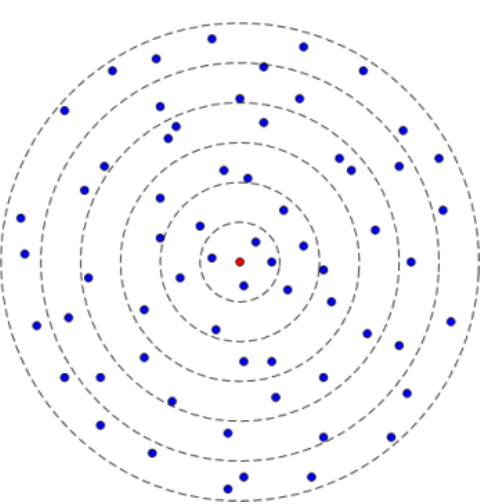
Figure 2. Concentric corona